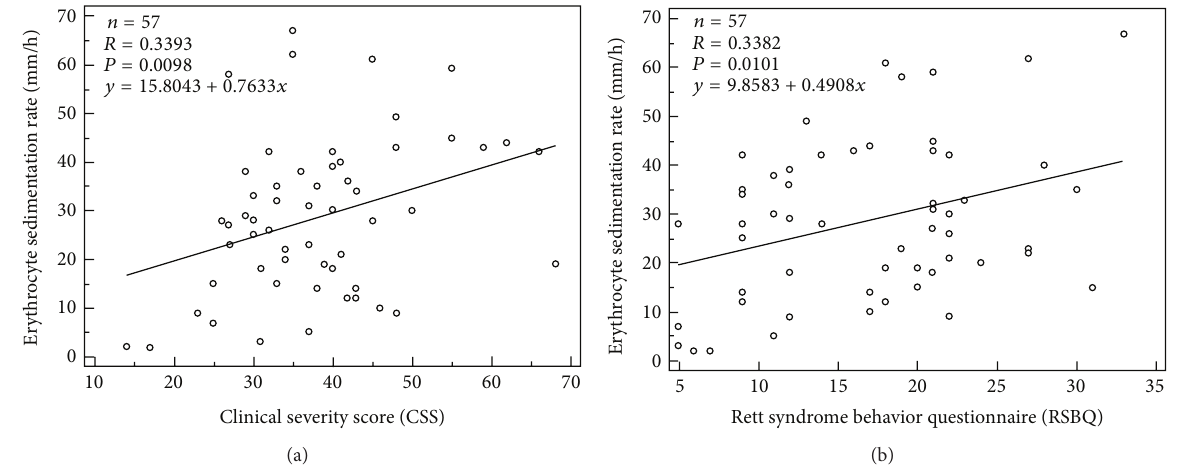
Figure 4: Statistically significant positive correlations were observed between erythrocytes sedimentation rate (ESR) and the clinical severity of the disease, as measured by (a) Clinical Severity Score (CSS) and (b) Rett Syndrome Behaviour Questionnaire